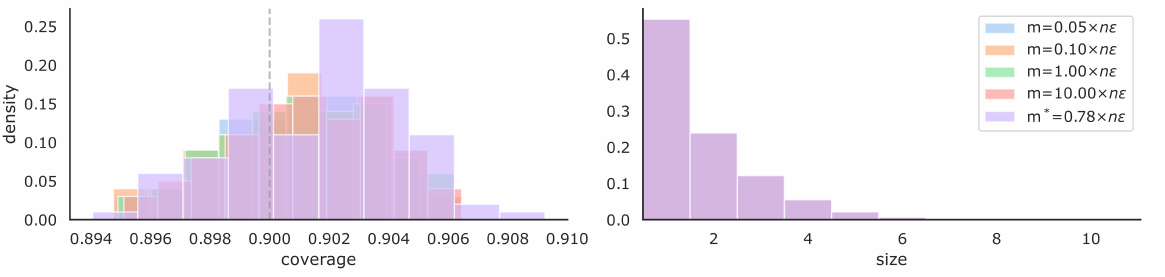
Figure 5: Coverage and set size for different values of m . We demonstrate the performance on Imagenet of private conformal prediction using a nonprivate ResNet-152 as the base model at α = 0 . 1 and ϵ = 1. The coverage is nearly constant over three orders of magnitude of bin numbers. All of the histograms on the right hand side are overlapping. See Section 4.2 for